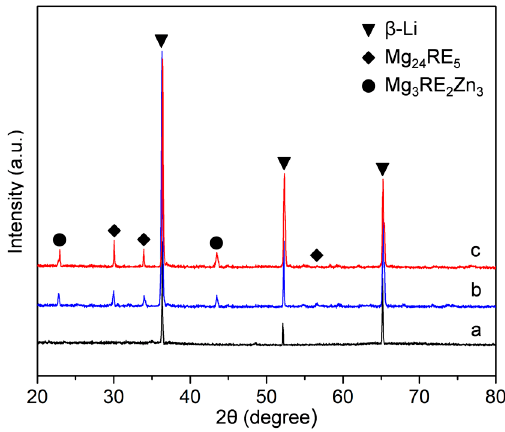
Figure 2. The X-ray diffractometer (XRD) patterns of the as-cast alloys: ( a ) Mg-11Li, ( b ) Mg-11Li-4Y-2Er-2Zn, and ( c ) Mg-11Li-8Y-4Er-4Zn.